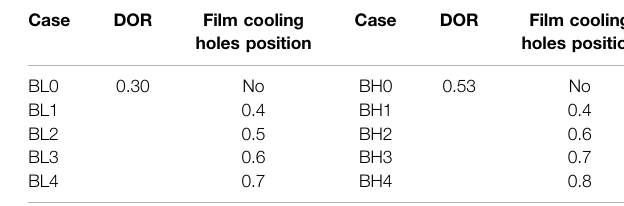
TABLE 1 | Research schemes for the effect of fi lm cooling hole position.